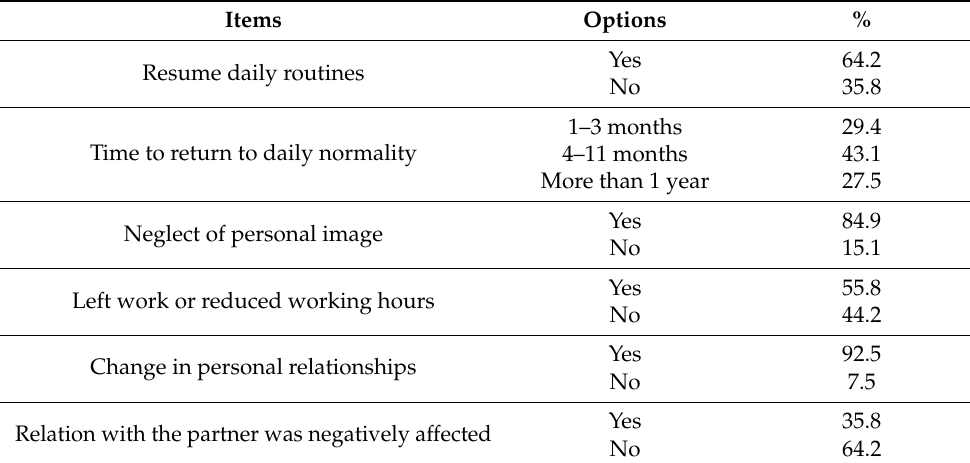
Table 3. Impact on the parents’ lives once at home after